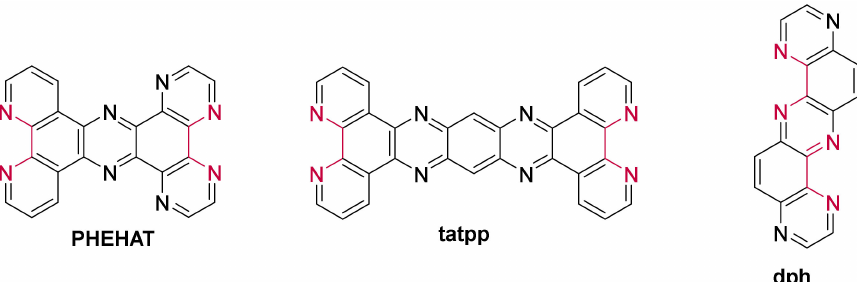
Figure 27. Structure of the π -extended ligands bridging ligands to form dinuclear ruthenium(II) complexes studied in the presence of